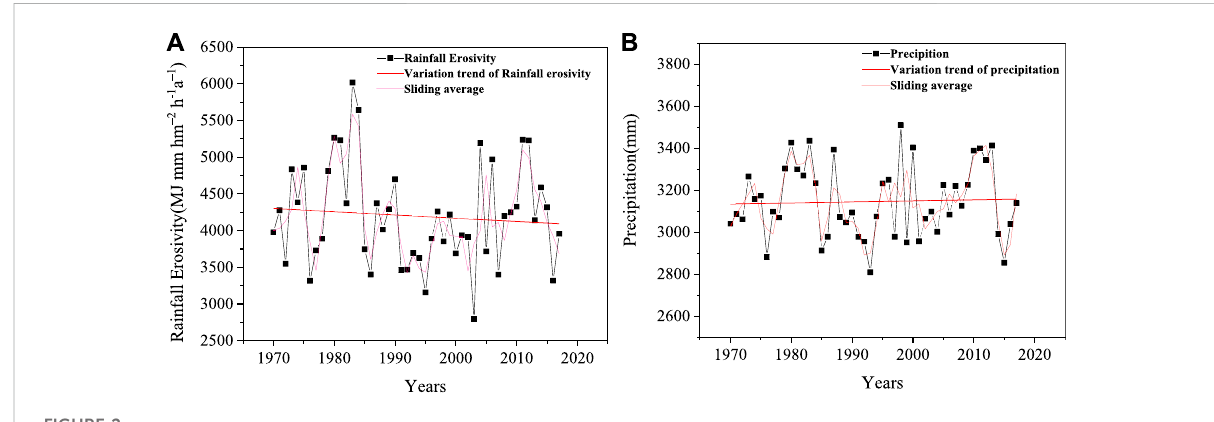
FIGURE 2 Trend analysis of RE (A) and precipitation (B) in Qinba Mountains.